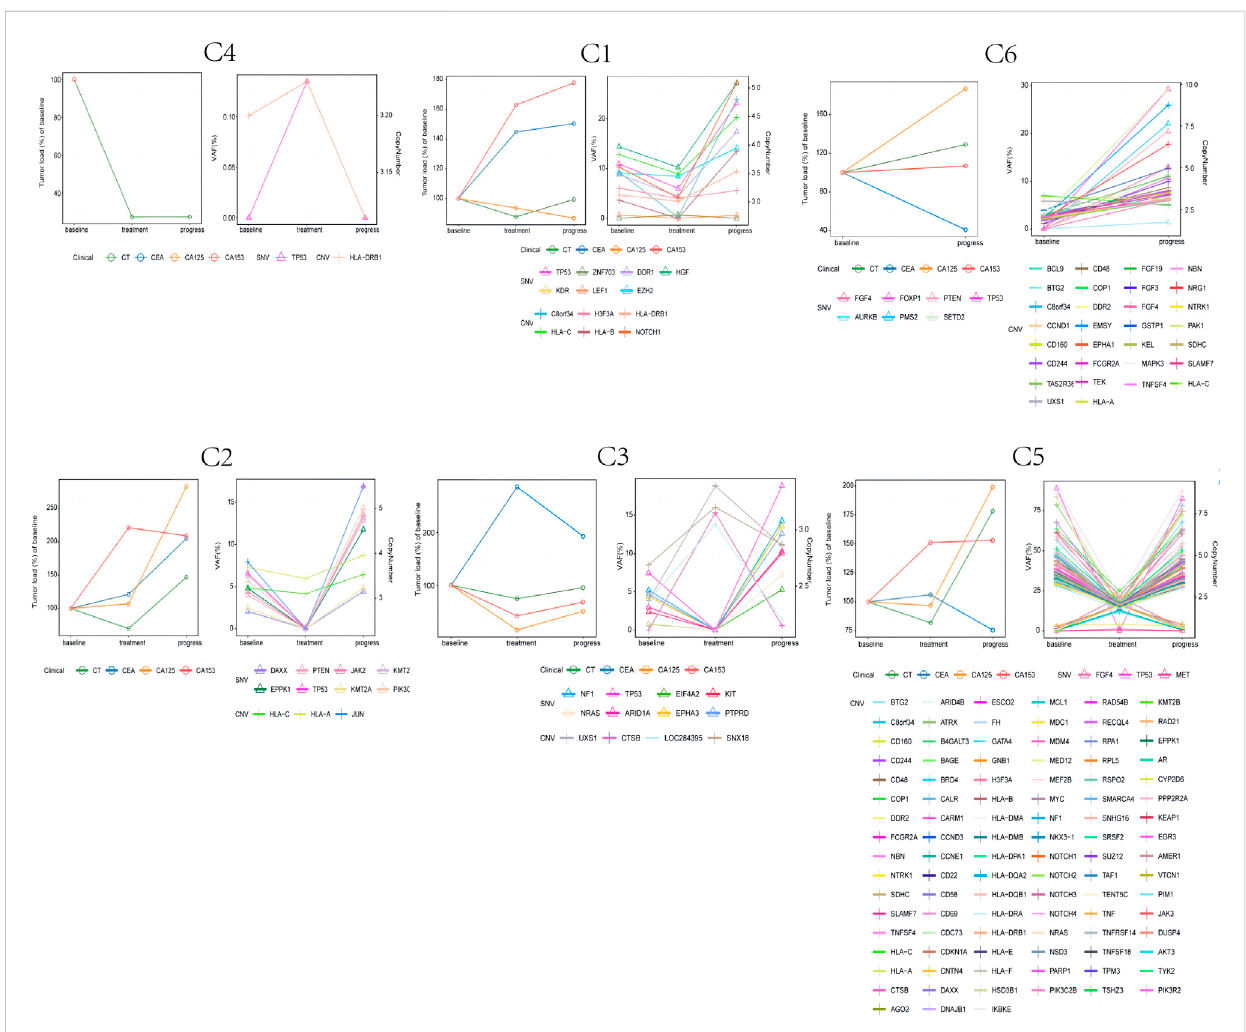
FIGURE 4 The dynamic changes of circulating tumor DNA (ctDNA) features (copy number variants (CNVs) and single-nucleotide variations (SNVs)), tumor burden, and CEA, CA125, and CA153 levels in six triple negative breast cancer (TNBC)